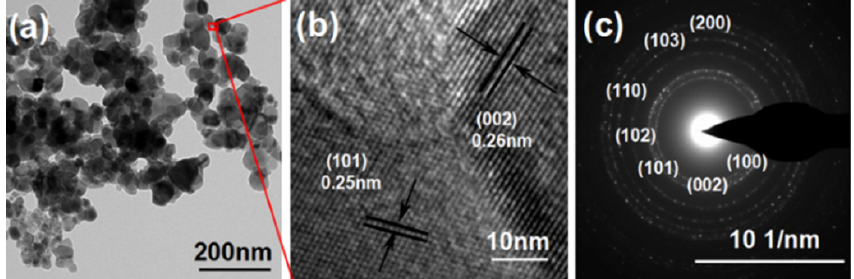
Figure 5. ( a ) Transmission electron microscopy (TEM) image; ( b ) high ‐ resolution TEM (HRTEM) image; and ( c ) selective area electron diffraction (SAED) pattern of nanoparticles scraped from the 2D ZnO IO film (CA/ZA molar ratio = 1:1).